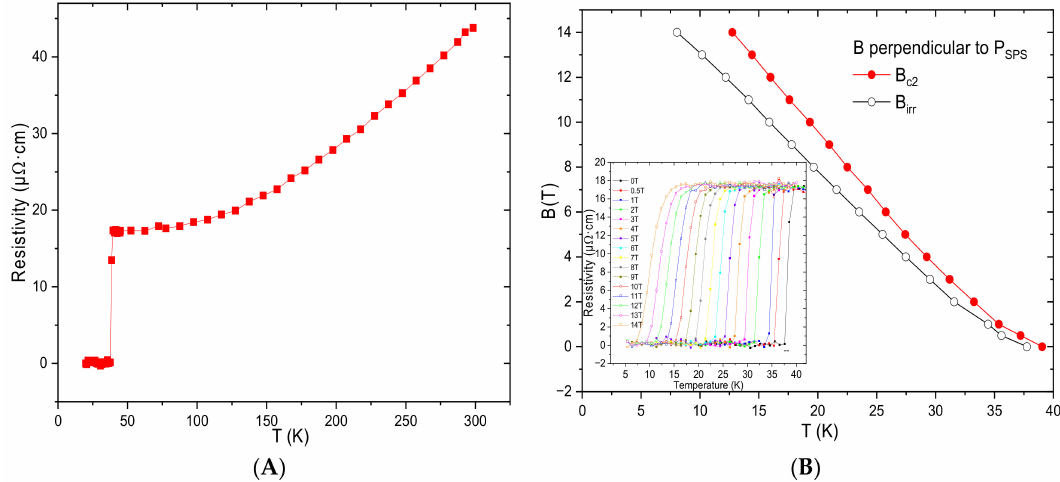
Figure 4. ( A ) Temperature dependence of the resistivity of sample A at 0 T with a 5 mA direct current. ( B ) Temperature dependence of B c2 and B irr for the same sample. The inset shows